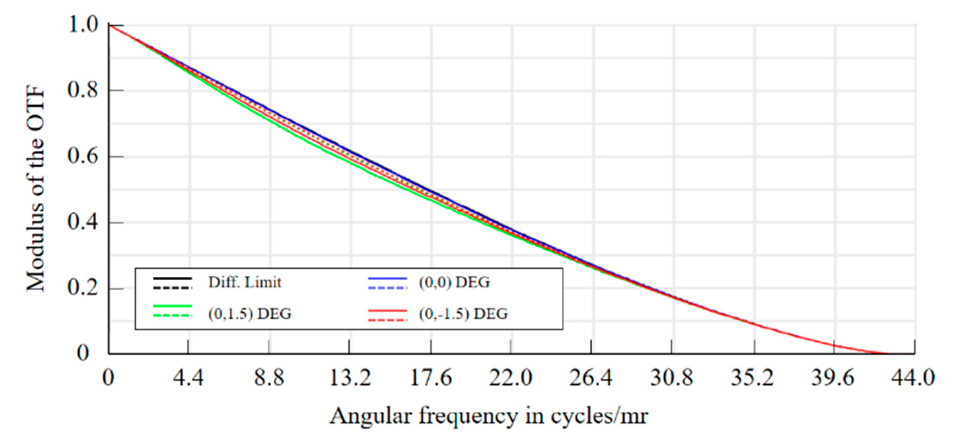
Table 6. Configuration parameters of the optimized off-axis four-mirror system.